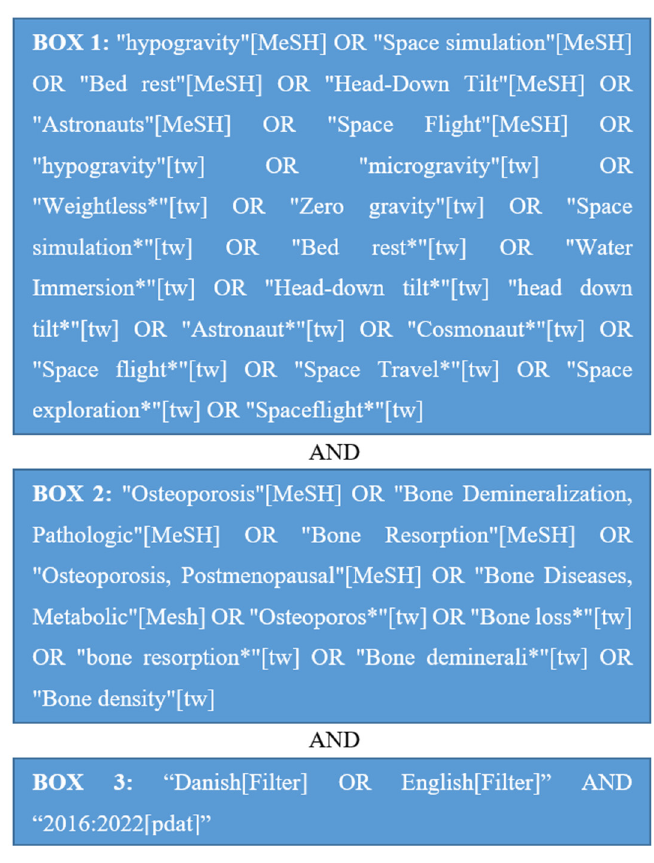
Figure 3. Search terms in PubMed.